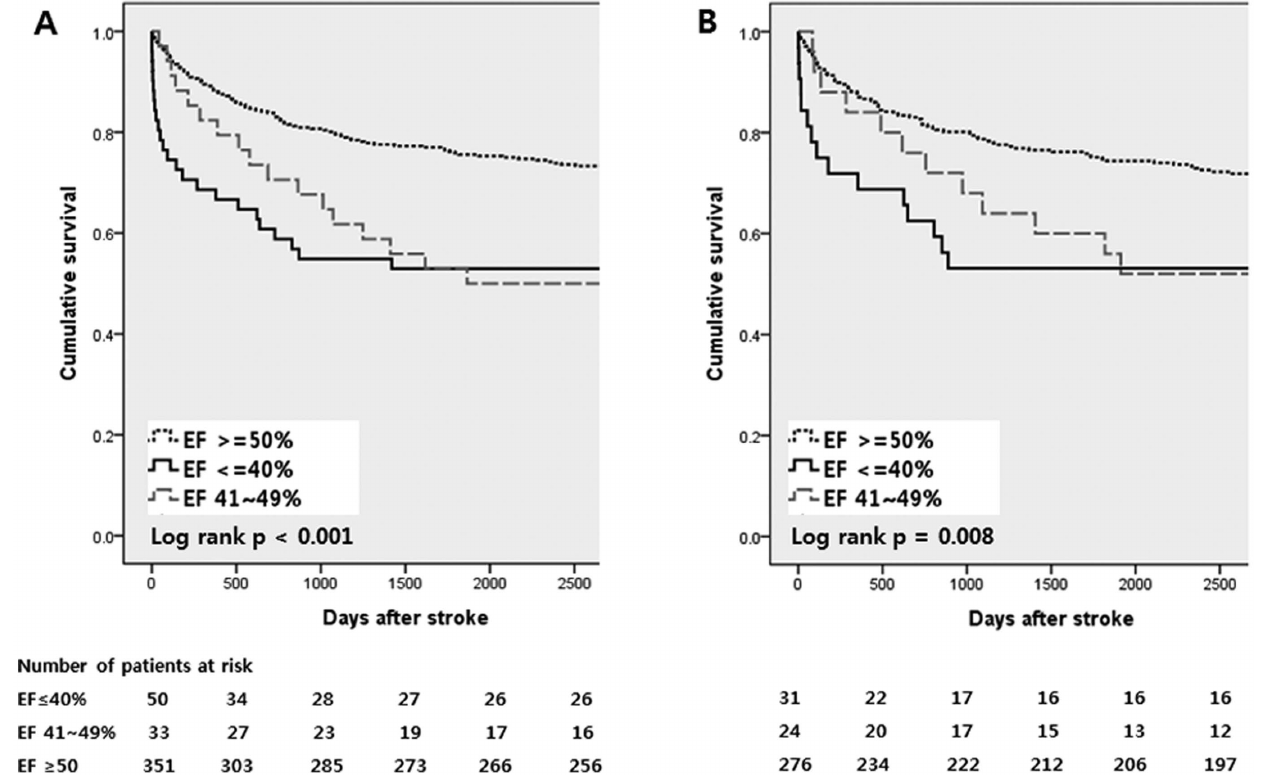
Figure 4. Kaplan-Meier curves of long-term mortality by EF groups in CES patients (A) and AF subgroup (B). Abbreviations: EF, Ejection fraction. CES: Cardioembolic stroke, AF: Atrial fibrillation.